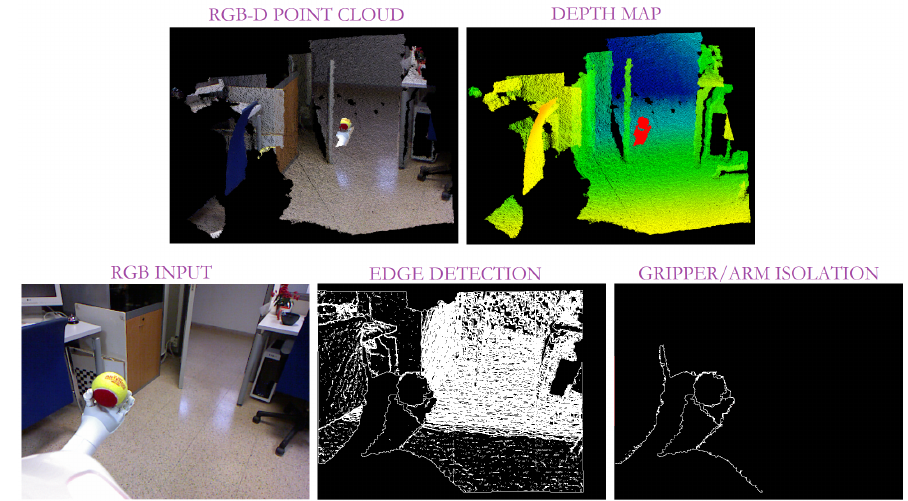
Figure 7. Results of our edge detection from depth information such that the bottom centre column represents the first contour segmentation, while the last one shows the contour segmentation after